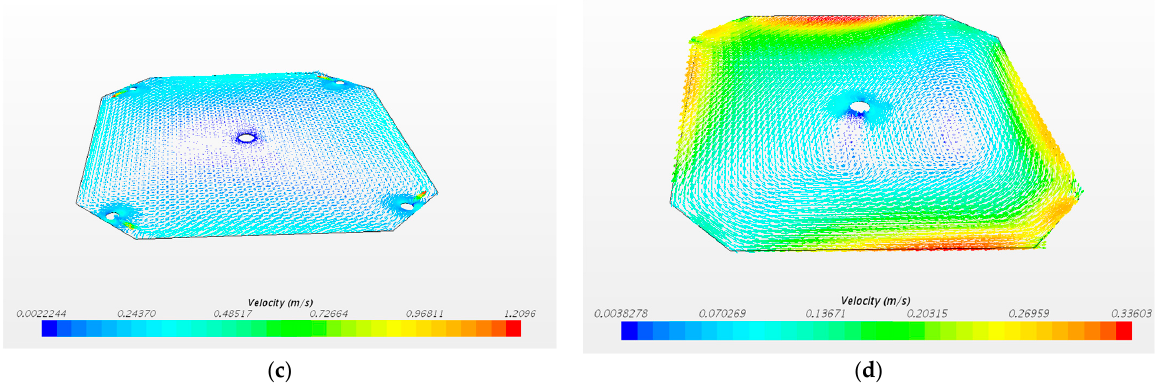
Figure 8. ( a ) middle longitudinal section, ( b ) H = 16.5 m cross section, ( c ) H = 8.5 m cross section, ( d ) H = 1.5 m cross section.